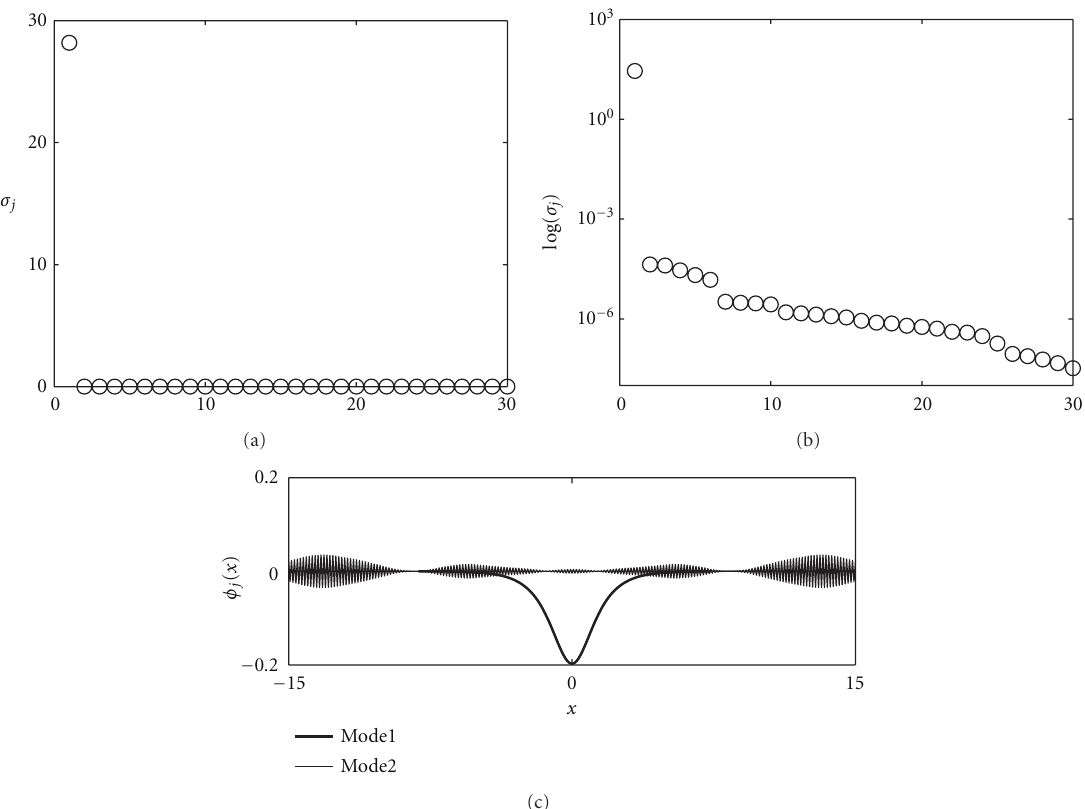
Figure 3: Projection of the N = 1 evolution to POD modes. The top two figures are the singular values σ j of the evolution demonstrated in (1) on both a regular scale and log scale. This demonstrates that the N = 1 soliton dynamics is primarily a single-mode dynamics. The first two modes are shown in the bottom panel. Indeed, the second mode is meaningless and is generated from noise and numerical roundo ff